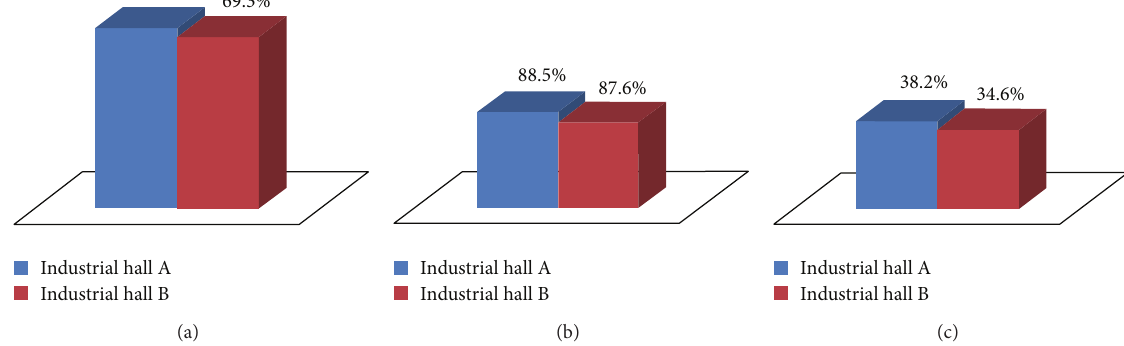
Figure 13: (a) Overall correct detection percentage; (b) correct detection percentage for large obstacles; (c) correct detection percentage for small objects.